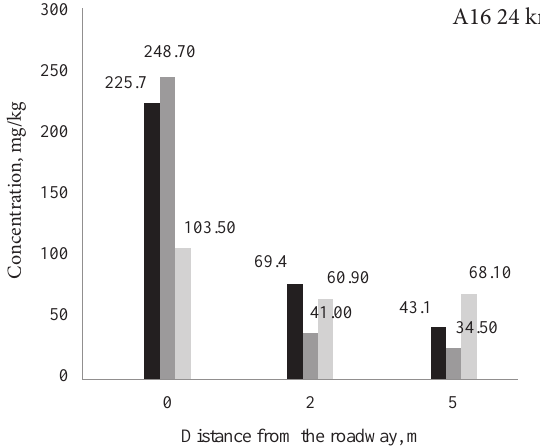
fig. 1 . Chloride concentration in soil at 24th km of Highway No